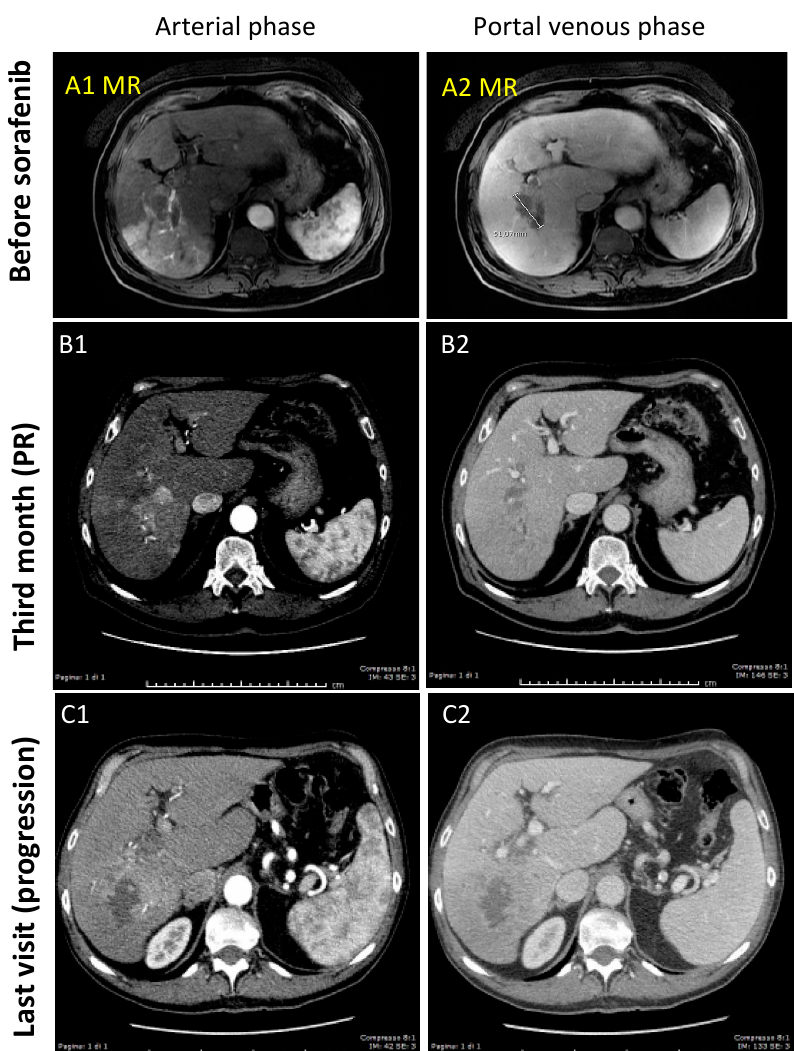
Figure 3. Baseline MRI ( A1 , A2 ) showing a widespread hypo-vascular HCC in liver segment IV, with complete thrombosis of the portal branch for the VII–VI liver segments. A partial response after 3 months of sorafenib therapy was documented by CT scans ( B1 , B2 ), which has been progressively lost, as shown at the last CT scan performed after 20 months of therapy ( C1 , C2 ). Model computed cancer cells daily rate production was 0.250 × C(t) 0.959 , and C(0) = 3.17 × 10 6 cells/mL. AFP was produced at the daily rate of 0.0015 × C(t); PIVKA-II at the daily rate of 0.0010 × C(t) 1.15 , and its mean lifetime was 3.3 days. Best fitting of C(t), AFP and PIVKA-II decline was obtained setting ϑ 1 = 50 and ψ 1 = 5, which yielded a 50.9% and 9.4% reduction in neo-angiogenesis and cancer cells replication, respectively. Both AFP and PIVKA-II levels showed fluctuations correlated to C(t), and best fitting was reached with Sp(t) and Tox(t) equal to 0 (Figure